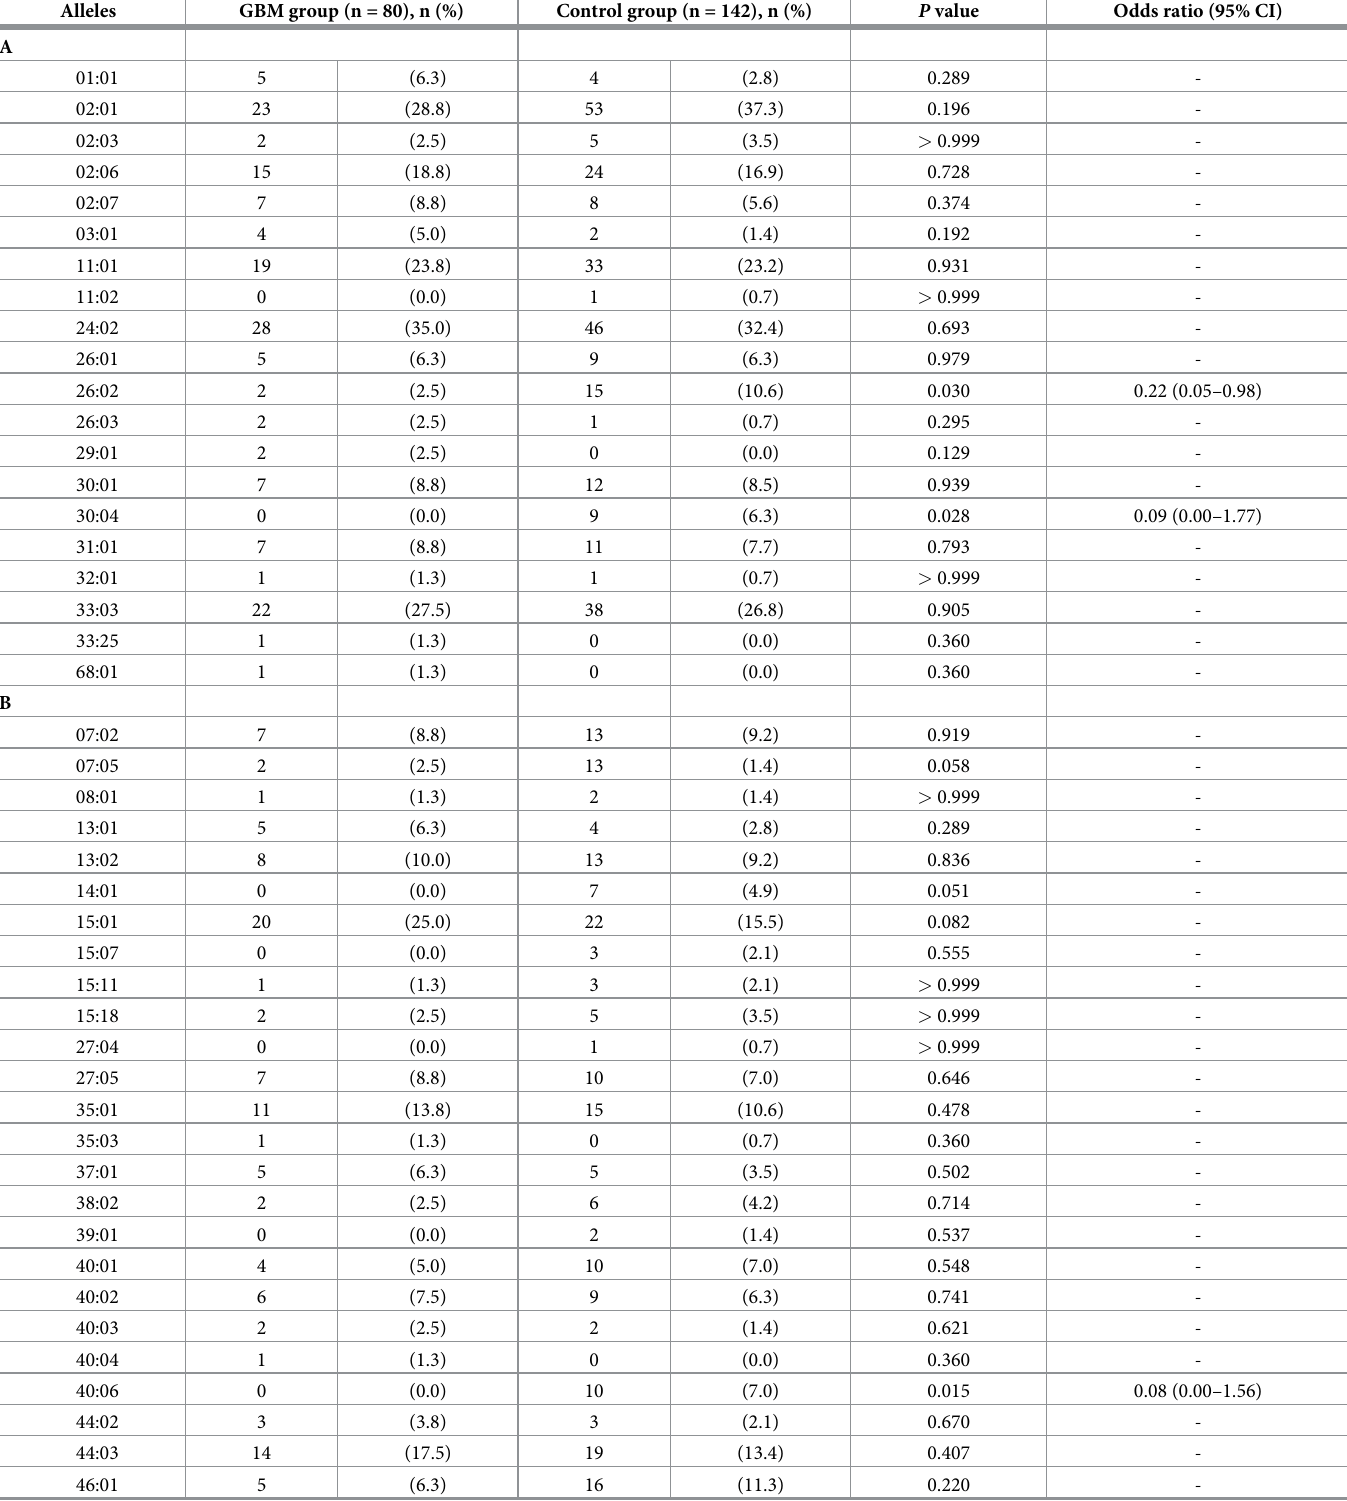
Table 2. HLA Class I allele frequencies in GBM and control groups.